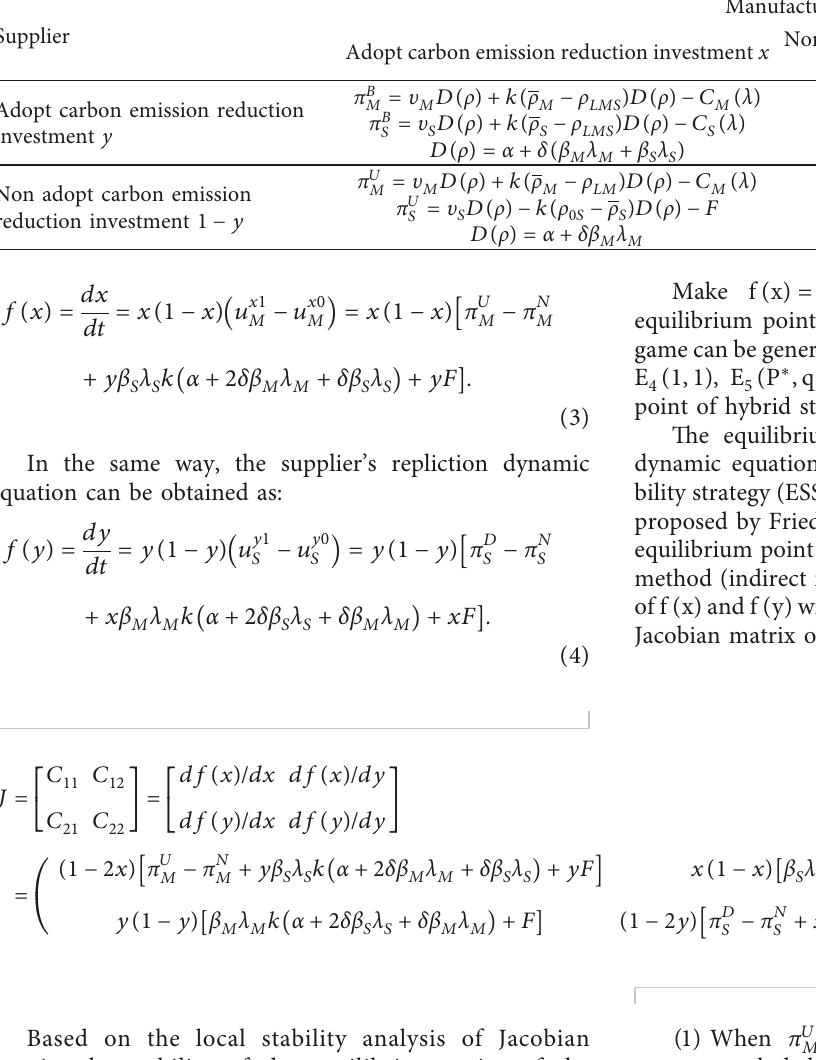
Table 1: Payment matrix of both parties in the game of carbon emission reduction investment behavior of supply chain enterprises.